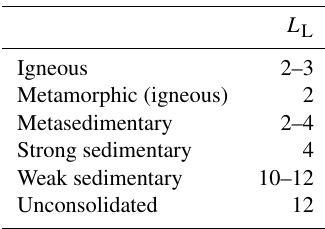
Table 3. Lithological erodibility index values based on the litholog- ical strength ( L L ; Eq. 7). Detailed sub-classifications per lithology can be found in Table